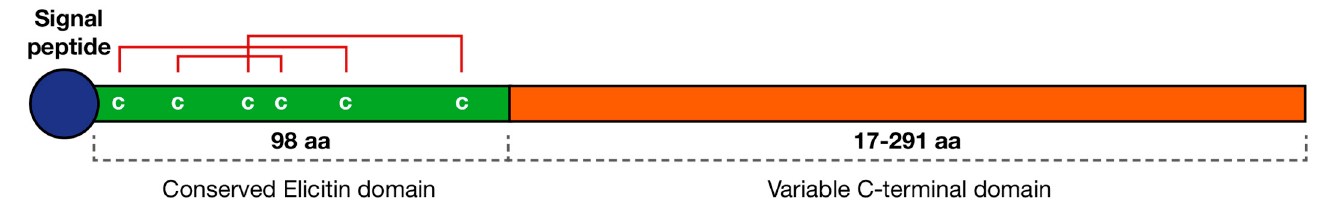
Figure 2. Structure of a Phytophthora elicitin. The conserved elicitin domain generally consists of 98 amino acids and contains 6 cysteine residues at conserved positions that form three disulphide bridges. The variable C-terminal tends to be rich in threonine, serine and proline residues. It was originally believed that elicitins induced cell death via the disruption of plasma membrane integrity upon sterol binding, but Phytophthora mutants producing elicitins unable to bind to plant sterols still elicited cell death responses [123,128]. Studies have shown that the elicitin-induced HR involves a ROS burst. It has been proposed that mitogen-activated protein kinases (MAPKs) phosphorylate WRKY7/8/9/11 TFs,